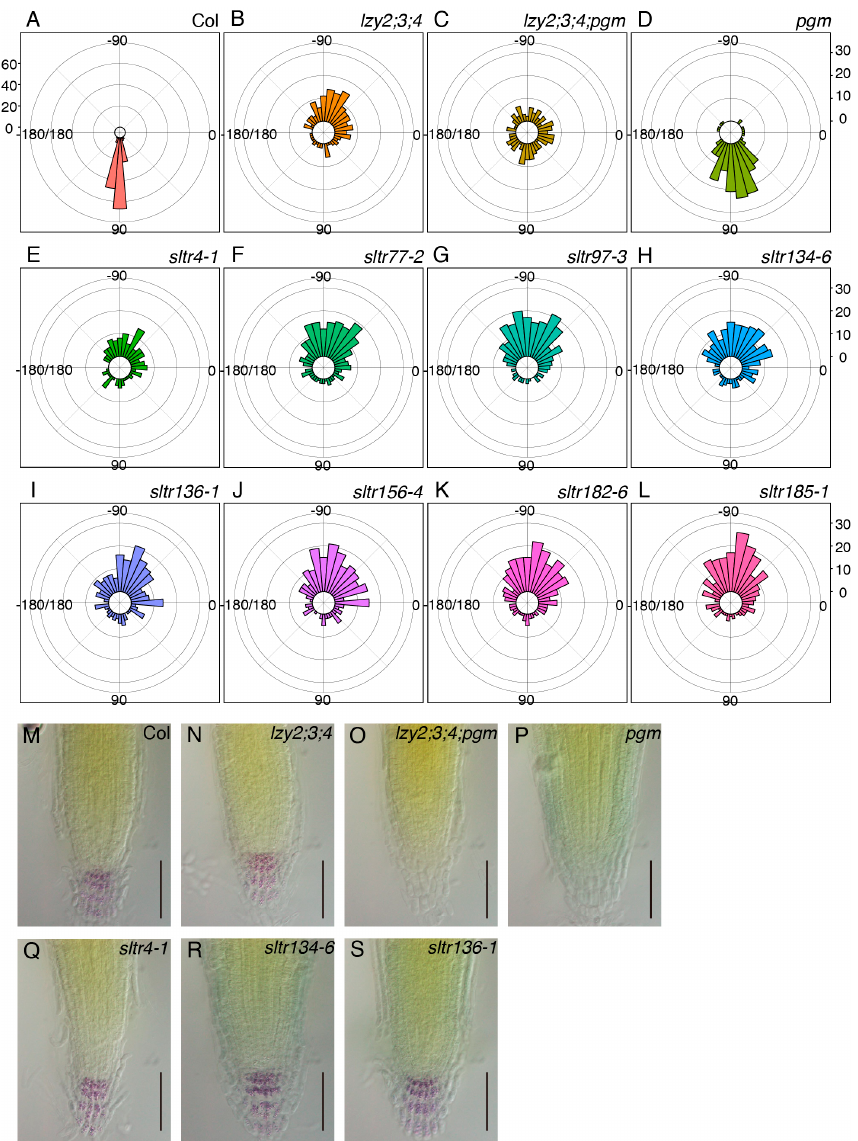
Figure 5. Genetic screening of lzy2;3;4 suppressors. Growth direction of primary roots in wild-type Col ( A ), lzy2;3;4 ( B ), lzy2;3;4;pgm ( C ), and pgm ( D ) and sltr candidates, sltr4-1 ( E ), sltr77-2 ( F ), sltr97-3 ( G ), sltr134-6 ( H ), sltr136-1 ( I ), sltr156-4 ( J ), sltr182-6 ( K ), and sltr185-1 ( L ). More than 150 plants were evaluated for all genotypes. Bars indicate the number of plants. Lugoal’s staining of primary roots of wild-type Col ( M ), lzy2;3;4 ( N ), lzy2;3;4;pgm ( O ), pgm ( P ), sltr134-6 ( Q ), sltr136-1 ( R ), and sltr156-4 ( S ) at 7 days after transferring to phytocabinet. Bars indicate 100 µm.